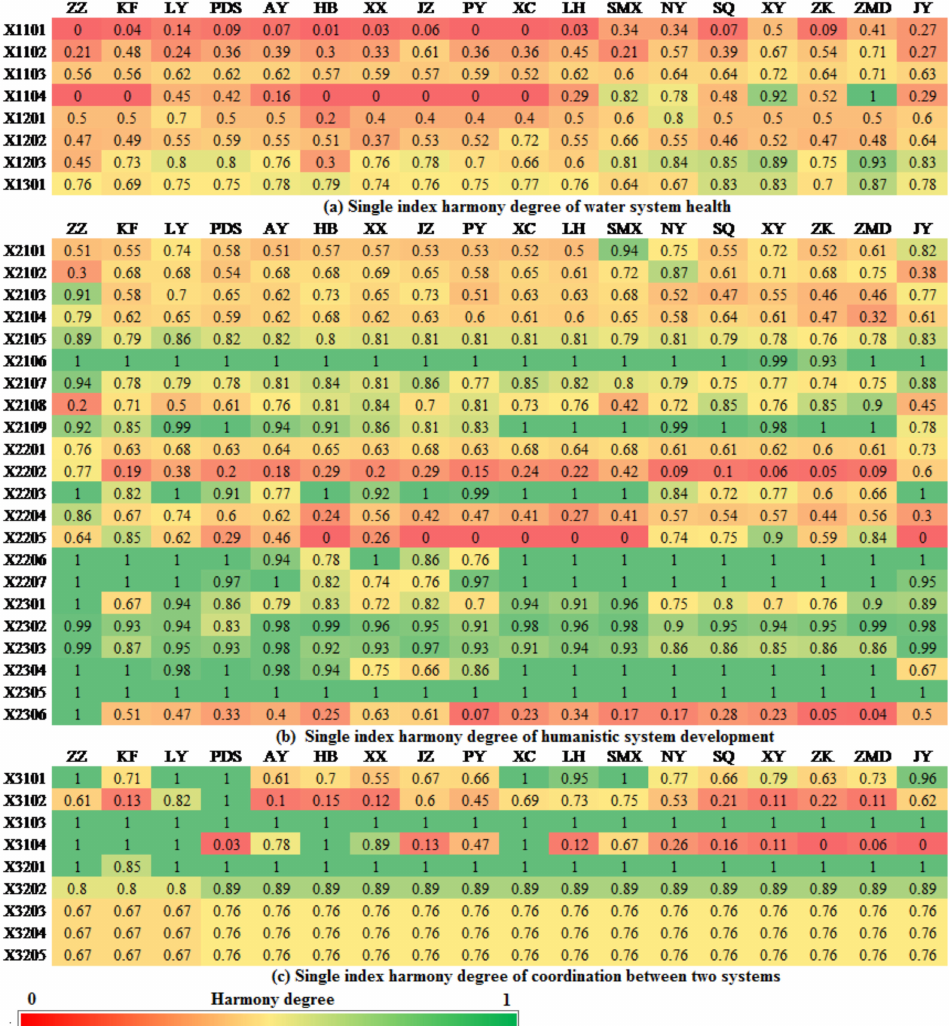
Figure 6. Comparison of single index harmony degree of human-water relationships (HWR) in Henan Province in 2018. In HDE, the indicators of X1201, X1202, and X1203 all belong to the water